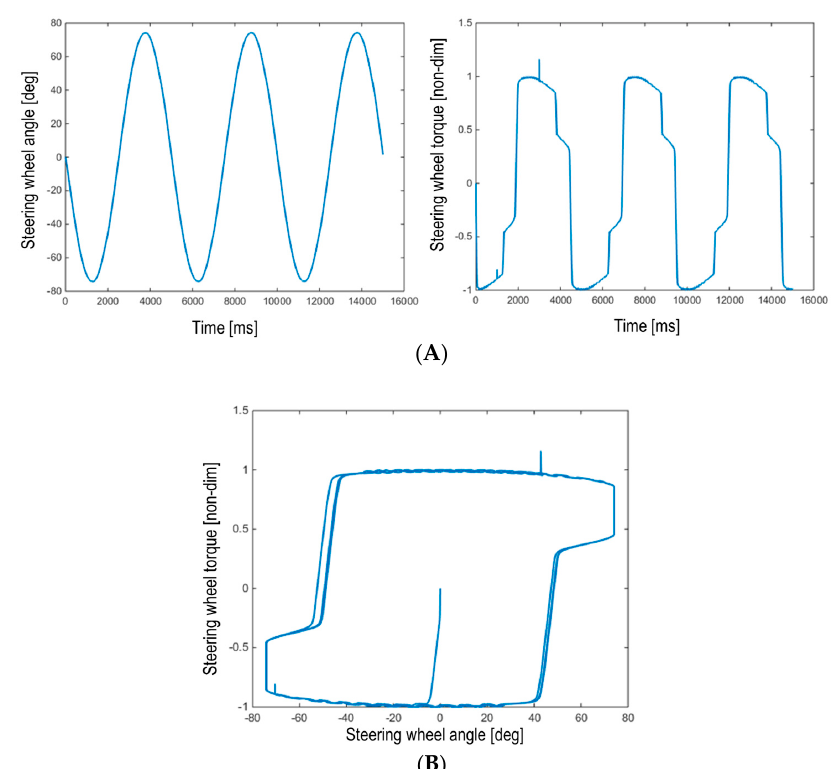
Figure 12. ( A ) Input steering wheel angle (0.2 Hz, amplitude 75 [°]) and steering wheel torque as function of the time [ms]; ( B ) steering wheel torque as function of the steering wheel angle.